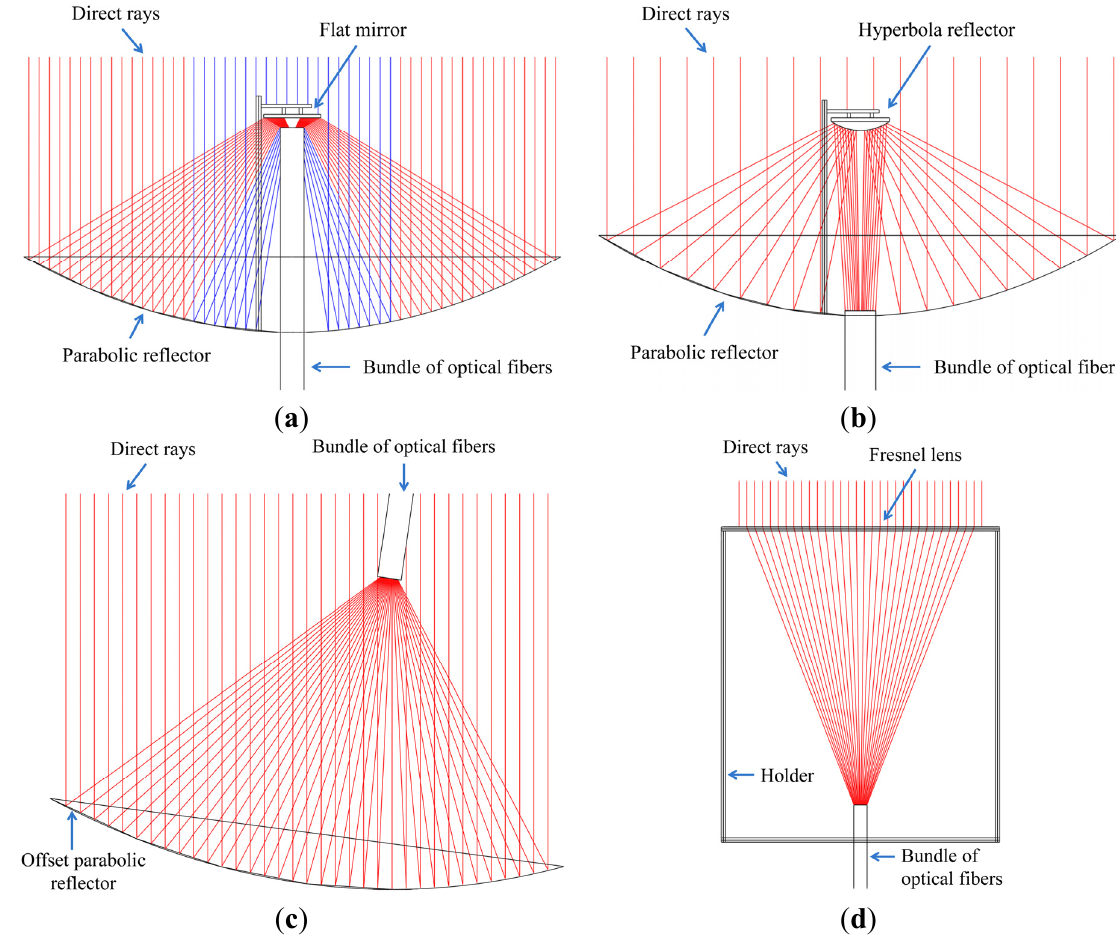
Figure 1. Physical layout of the daylighting system for the ( a ) parabolic and flat reflectors; ( b ) parabolic and hyperbola reflectors; ( c ) offset parabolic reflector; and ( d ) Fresnel